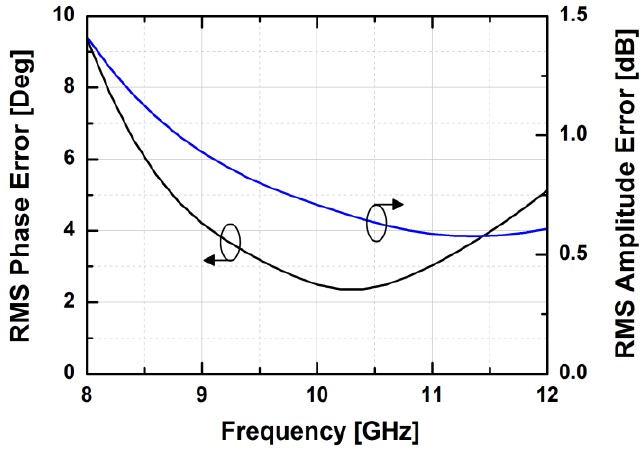
Figure 28. The worst RMS phase and amplitude errors vs. frequency in all of the TRM phase shift states.